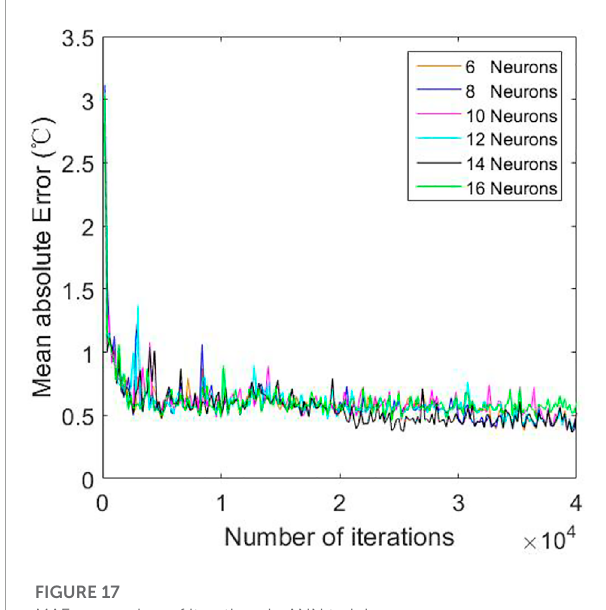
MAE vs . number of iterations in ANN training.